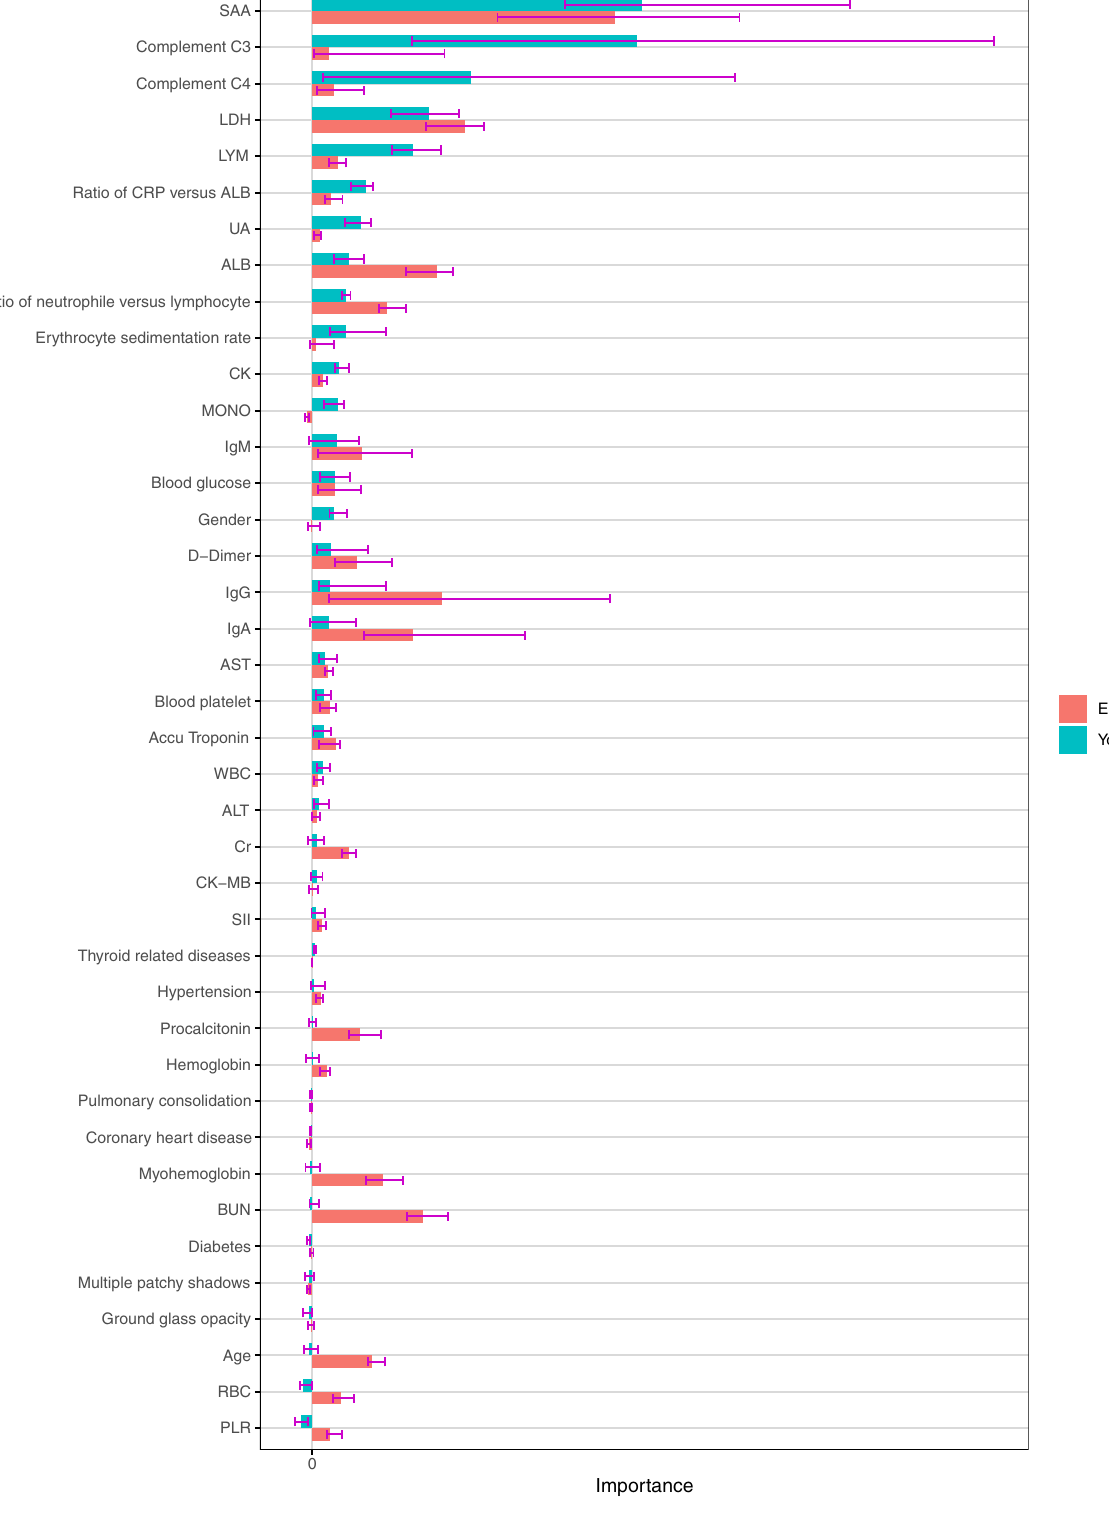
Figure 1. AUC variable importance with respect to predicting the outcome “severe versus mild” for young and elderly patients calculated using random forests. The larger the importance value of a covariate is, the greater the improvement in prediction performance by including this covariate in prognosis. Complement C3, C4, LYM, the ratio of CRP versus ALB, and UA seem to influence the prognosis of the development of severity mostly in young patients. The bars show the medians of the 20 importance values calculated using the 20 imputed data sets from the multiple imputation. The error bars illustrate the variabilities of the importance values: The lower/upper ends show the first/third quartiles of the 20 importance values, that is, 25% percent of the importance values lie below/above these values. To make the raw importance values comparable between young and elderly patients, both for the young and for the elderly patients, the raw importance values were divided by the means of all importance values with positive